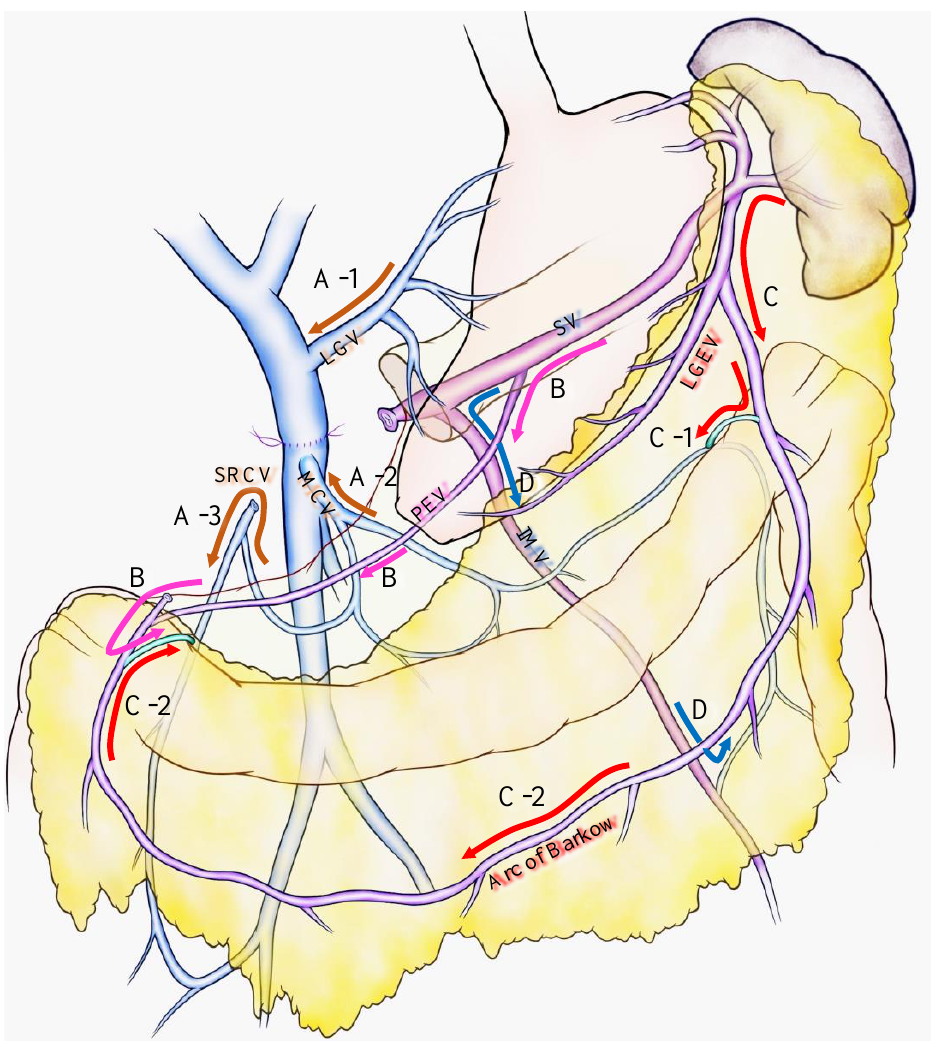
Figure 1. Various venous flow form spleen after portal-superior mesenteric vein confluence resection. Brown arrows indicate the critical veins: ( A-1 ) LGV, ( A-2 ) MCV, ( A-3 ) and SRCV arcade. ( B ) Pink arrows indicate the route from the SV to the PEV and the colonic marginal vein. ( C ) Red arrows indicate the route from the SV to the LGEV and the arc of Barkow; ( C-1 ) the connection between the arc of Barkow and the colonic marginal vein at the left side of the transverse colon; ( C-2 ) the connection between the arc of Barkow and the colonic marginal vein at the right side of the transverse colon. ( D ) Blue arrows indicate the route from the SV to the IMV and colonic marginal vein. IMV: inferior mesenteric vein; LEGV: left gastric epiploic vein; LGV: left gastric vein; MCV: middle colic vein; PEV: posterior epiploic vein; SV: splenic vein; SRCV: superior right colic